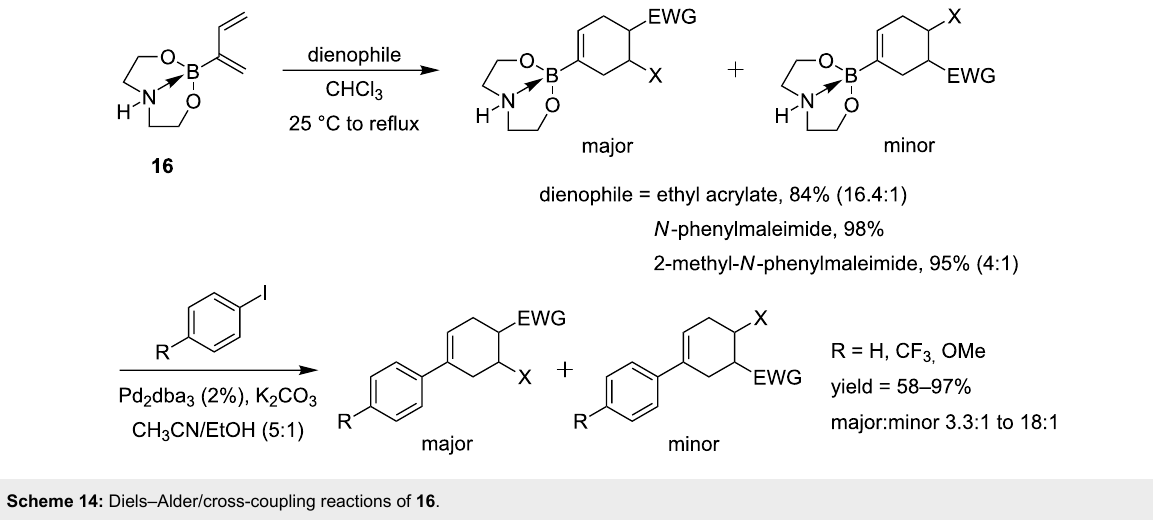
Scheme 14: Diels–Alder/cross-coupling reactions of 16 .